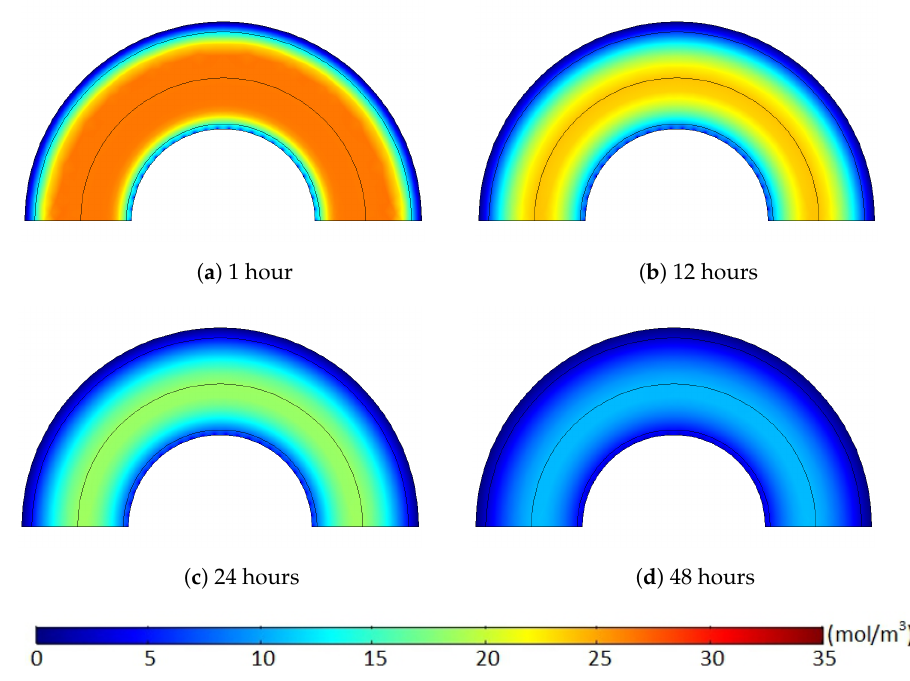
Figure 14. Methane concentration (mol/m 3 ) over time where the initial methane concentration is uniform. The degassing temperature is 343.15 K and C l = 1/90. ( a ) 1 hours, ( b ) 12 hours, ( c ) 24 hours, ( d ) 48 hours.